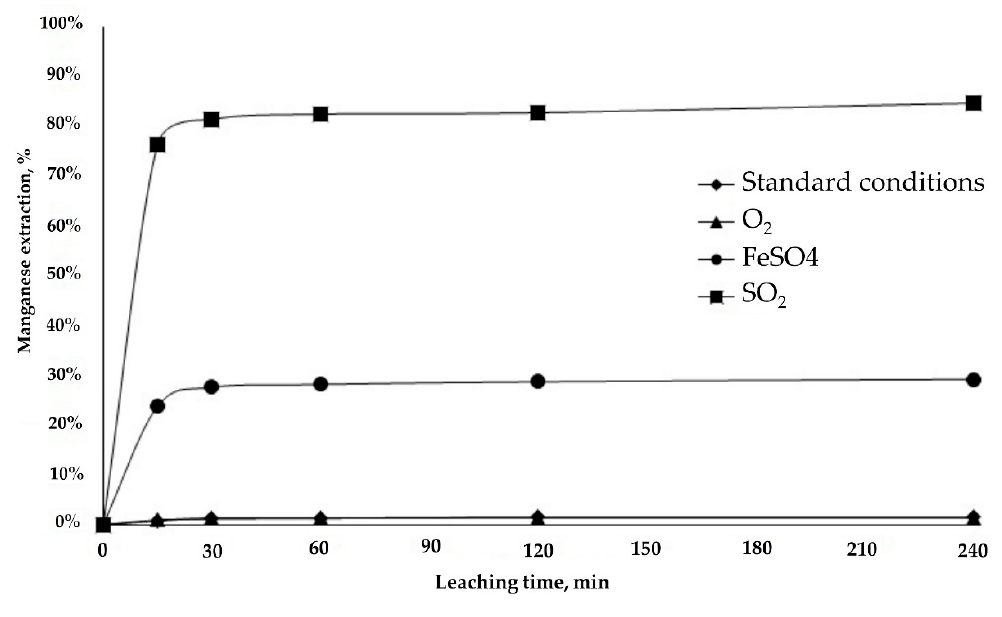
Figure 7. Manganese extraction from RA sample.